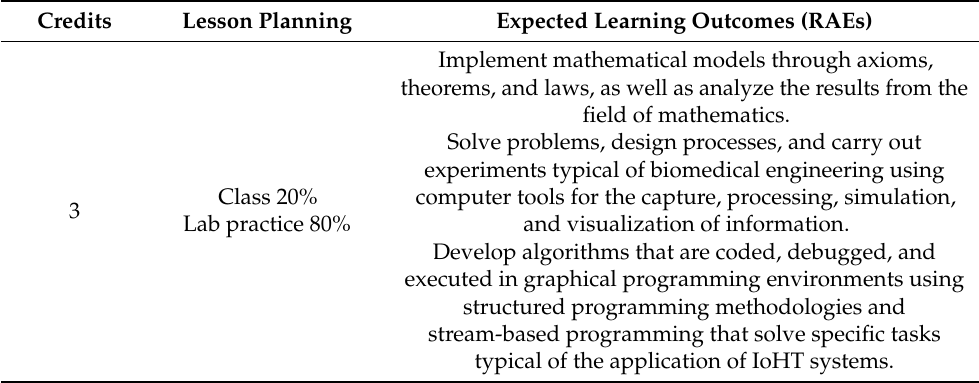
Table 2. Learning outcomes description for the course with credits, lesson planning, and